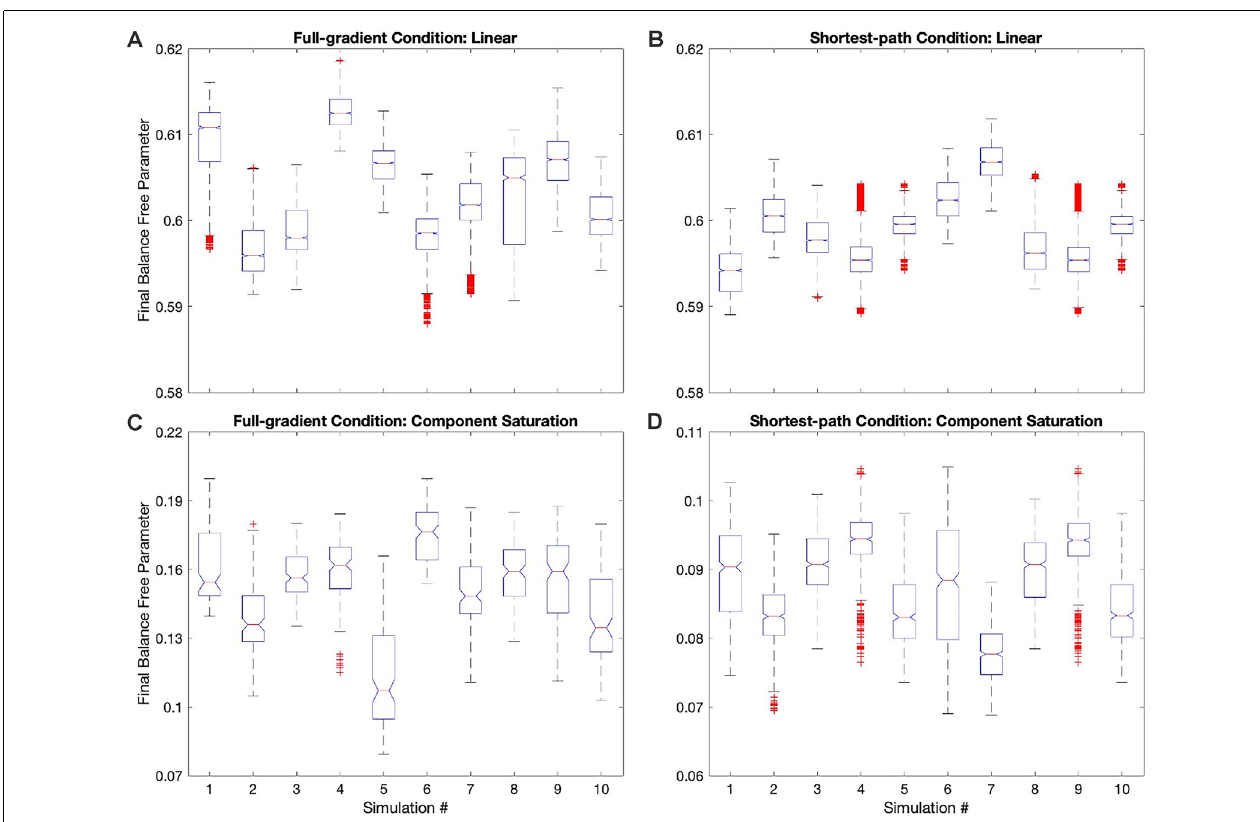
FIGURE 7 | Box plots of the final balance free parameter in each of the simulations of four conditions in Table 1 . (A) Full-gradient delta rule with linear value function. (B) Shortest-path (Phi) rule with linear value function. (C) Full-gradient delta rule with Component-saturation value function. (D) Shortest-path (Phi) rule with Component-saturation value function. Each box plot contains the 10 simulations of the indicated condition. On each box, the central mark is the median, and the edges of the box are the 25th and 75th percentiles. The whiskers are extended to the most extreme data points that are not considered outliers, with those being plotted individually using red “+” symbols. Box plots include notches for the comparison of the median values. Two medians are significantly different at the 5% significance level if their intervals, represented by notches, do not overlap. In all these four examples, the median final balance free parameters varied significantly across the